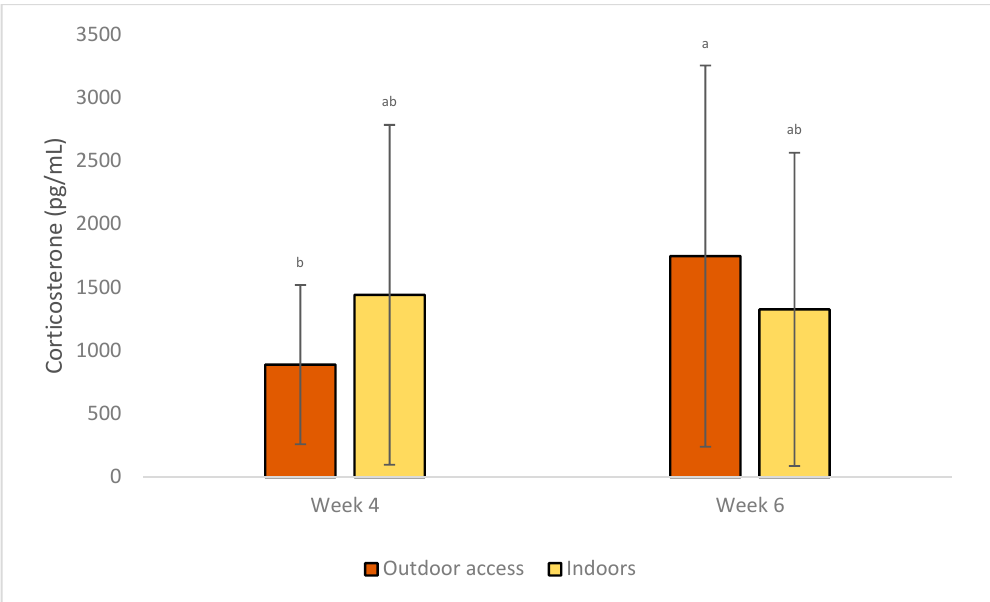
Figure 5. LS Means of the effects of system × week on corticosterone concentration of commercial-line broilers. Different superscript letters indicate statistically significant differences (Tukey’s HSD test; p ≤ 0.05).